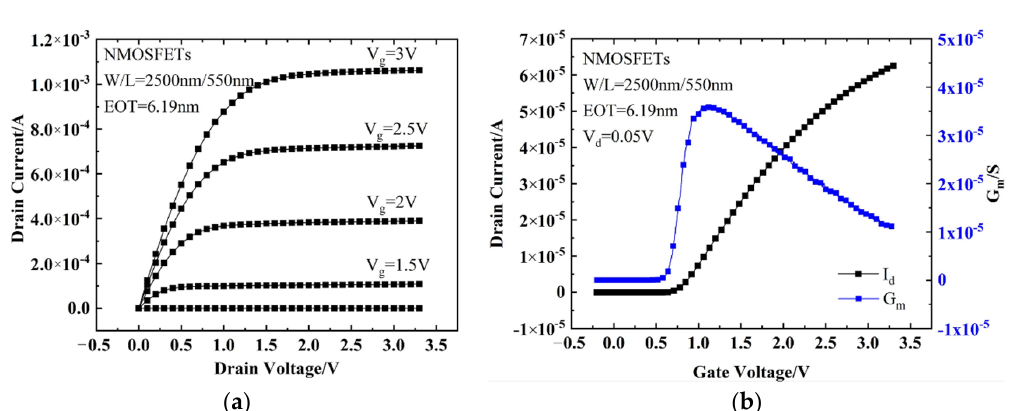
Figure 1. I − V characteristics for a typical NMOSFET in this work: ( a ) output characteristics and ( b ) transfer and transconductance curves.